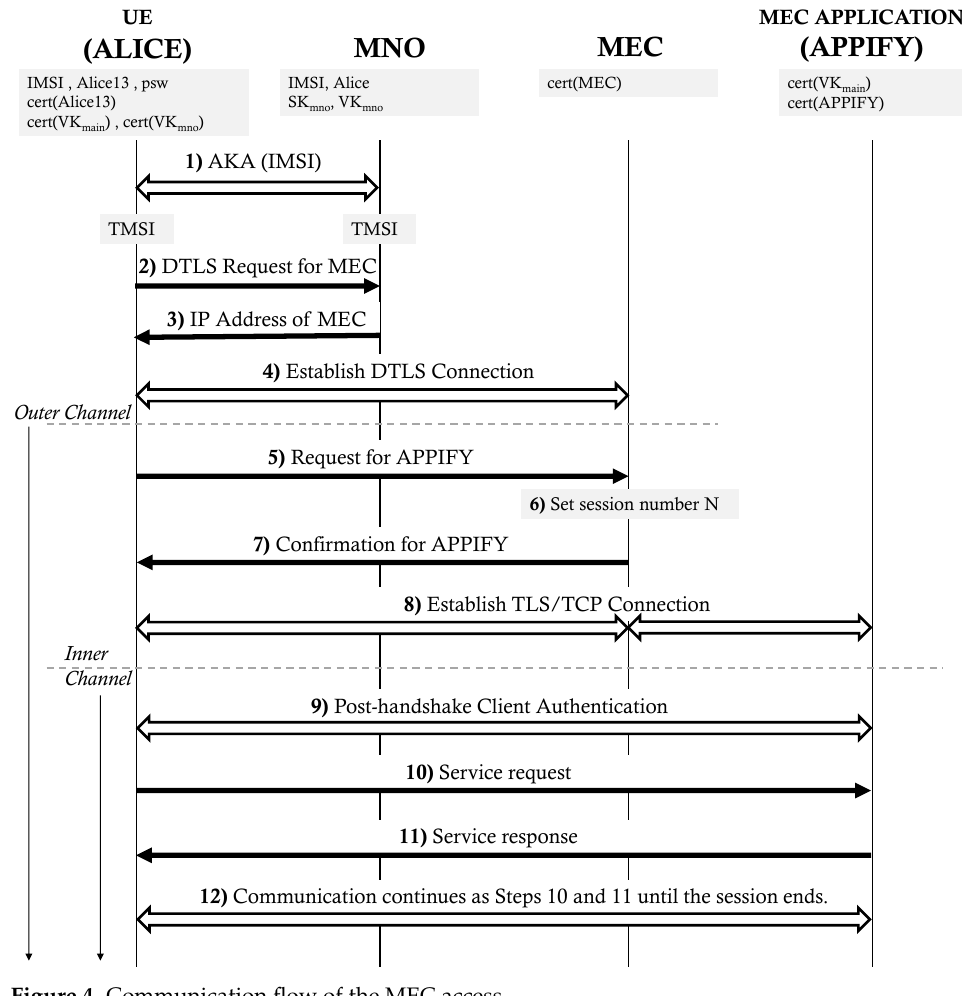
Figure 4. Communication flow of the MEC